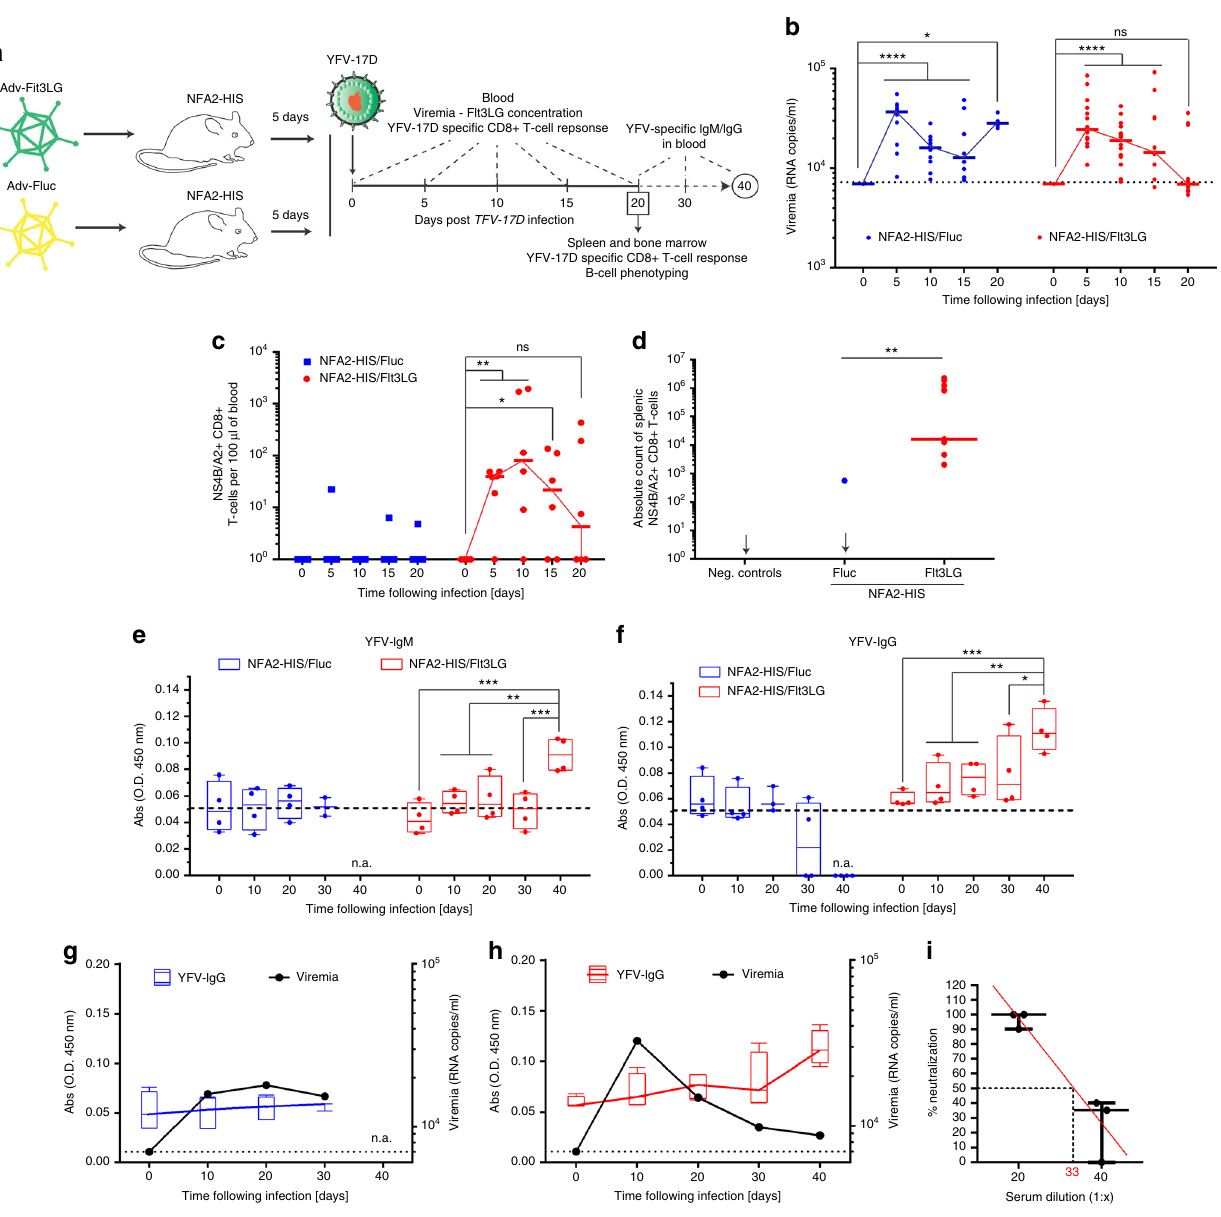
Fig. 7 NFA2-HIS/Flt3LG mice mount YFV-speci fi c cellular and humoral response. a Schematic representation of the NFA2-HIS mice time course infection experiment. b YFV-17D serum viremia in the peripheral blood of NFA2-HIS/Fluc (blue, n = 10) and NFA2-HIS/Flt3LG (red, n = 14) mice over the course of infection. ( + ) RNA copies per ml were quanti fi ed by RT-qPCR. Limit of detection (dotted line) is shown. Horizontal lines represent median viremia at each time point. * p ≤ 0.05, **** p ≤ 0.0001, ns non-signi fi cant (Wilcoxon – Mann – Whitney test). c Absolute cell count of peripheral YFV-speci fi c CD8 + T cells (NS4B/A2 + ) in the blood of NFA2-HIS/Fluc and NFA2-HIS/Flt3LG mice over the course of YFV-17D infection. Cell counts are shown as per 100 μ l of total blood. Horizontal lines represent median cell count at each time point ( n = 4 – 6). * p ≤ 0.05, ** p ≤ 0.01, ns non-signi fi cant (Wilcoxon – Mann – Whitney test). d Absolute count of YFV-speci fi c CD8 + T cells (NS4B/A2 + ) in the spleen of NFA2-HIS/Fluc and NFA2-HIS/Flt3LG mice at day 20 post infection. Negative controls represent one non-infected NFA2-HIS/Flt3LG mouse and two infected NRGF-HIS/Flt3LG mice (that do not express HLA-A2). Horizontal lines represent median cell count ( n = 4 – 11). ** p ≤ 0.01 (Wilcoxon – Mann – Whitney test). e , f Relative concentration of human anti-YFV-17D IgM ( e ) and IgG ( f ) antibodies in the serum of NFA2-HIS/Fluc (blue, n = 4) and NFA2-HIS/Flt3LG mice (red, n = 4) over a 6-weeks course of infection. ** p ≤ 0.01, *** p ≤ 0.001, ns non-signi fi cant (Wilcoxon – Mann – Whitney test). n.a. non applicable as no mice were analyzed at the time of serum collection. g , h Correlation between YFV-17D viremia (black line) and YFV-IgG relative concentration (colored box and whisker) in the serum of NFA2-HIS/Fluc ( g ) and NFA2-HIS/Flt3LG ( h ) over a 6-weeks course of infection ( n = 4 per group). Medians in each box and whisker are connected together by a colored line (blue for NFA2-HIS/Fluc and red for NFA2-HIS/Flt3LG). Viremia limit of detection (dotted line) is shown. n.a. non applicable as no mice in the control group were alive at the time of serum collection. For panels ( e – h ), bounds of box and whiskers represent the min-to-max absorbance value at each time point. Medians are indicated in each box as center line. i Quanti fi cation of YFV-neutralizing activity in the serum of NFA2-NRGF-HIS/Flt3LG mice. Serum neutralizing activity is represented as percentage of YFV-17D infection inhibition (% neutralization). Medians with ranges (min-to-max percentage of neutralization) for both serum dilution are shown ( n = 3). A linear regression (red line) of the average neutralization activity is shown and was used to determine the median neutralization titer (50% inhibition, red number on the x